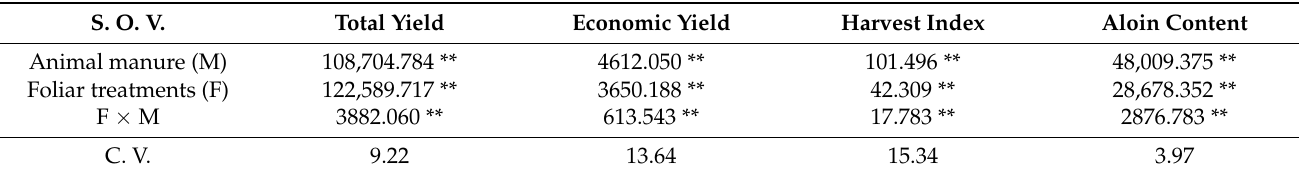
Table 6. ANOVA for the effect of soil-based animal manure (no-manure, 10%, and 20% v / v ) use and foliar applications (no-foliar, salicylic acid, cerium oxide nanoparticles, and CeO 2 : SA-nanoparticles) on Aloe vera L. plants’ aloin content and yield traits.